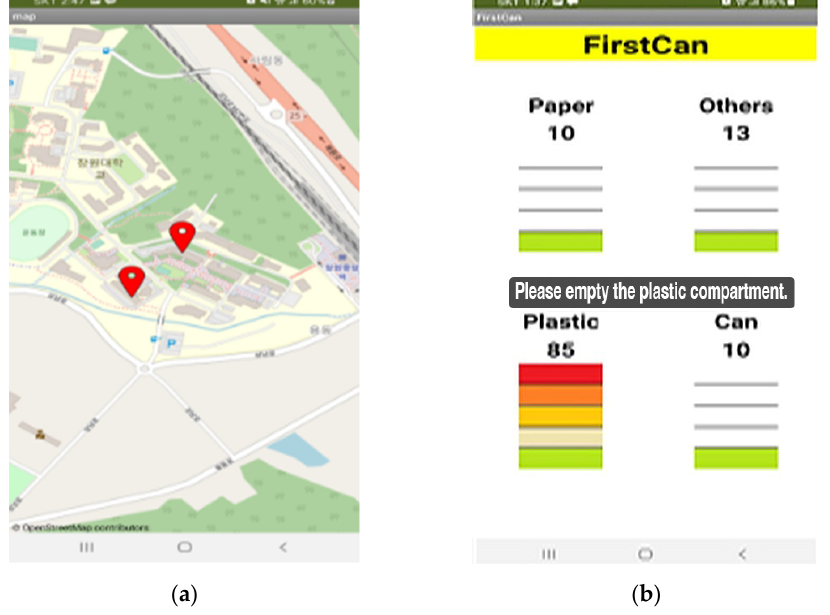
Figure 12. Screenshot of the mobile application for showing the trash bin location on the map ( a ) and the trash bin capacity ( b ).